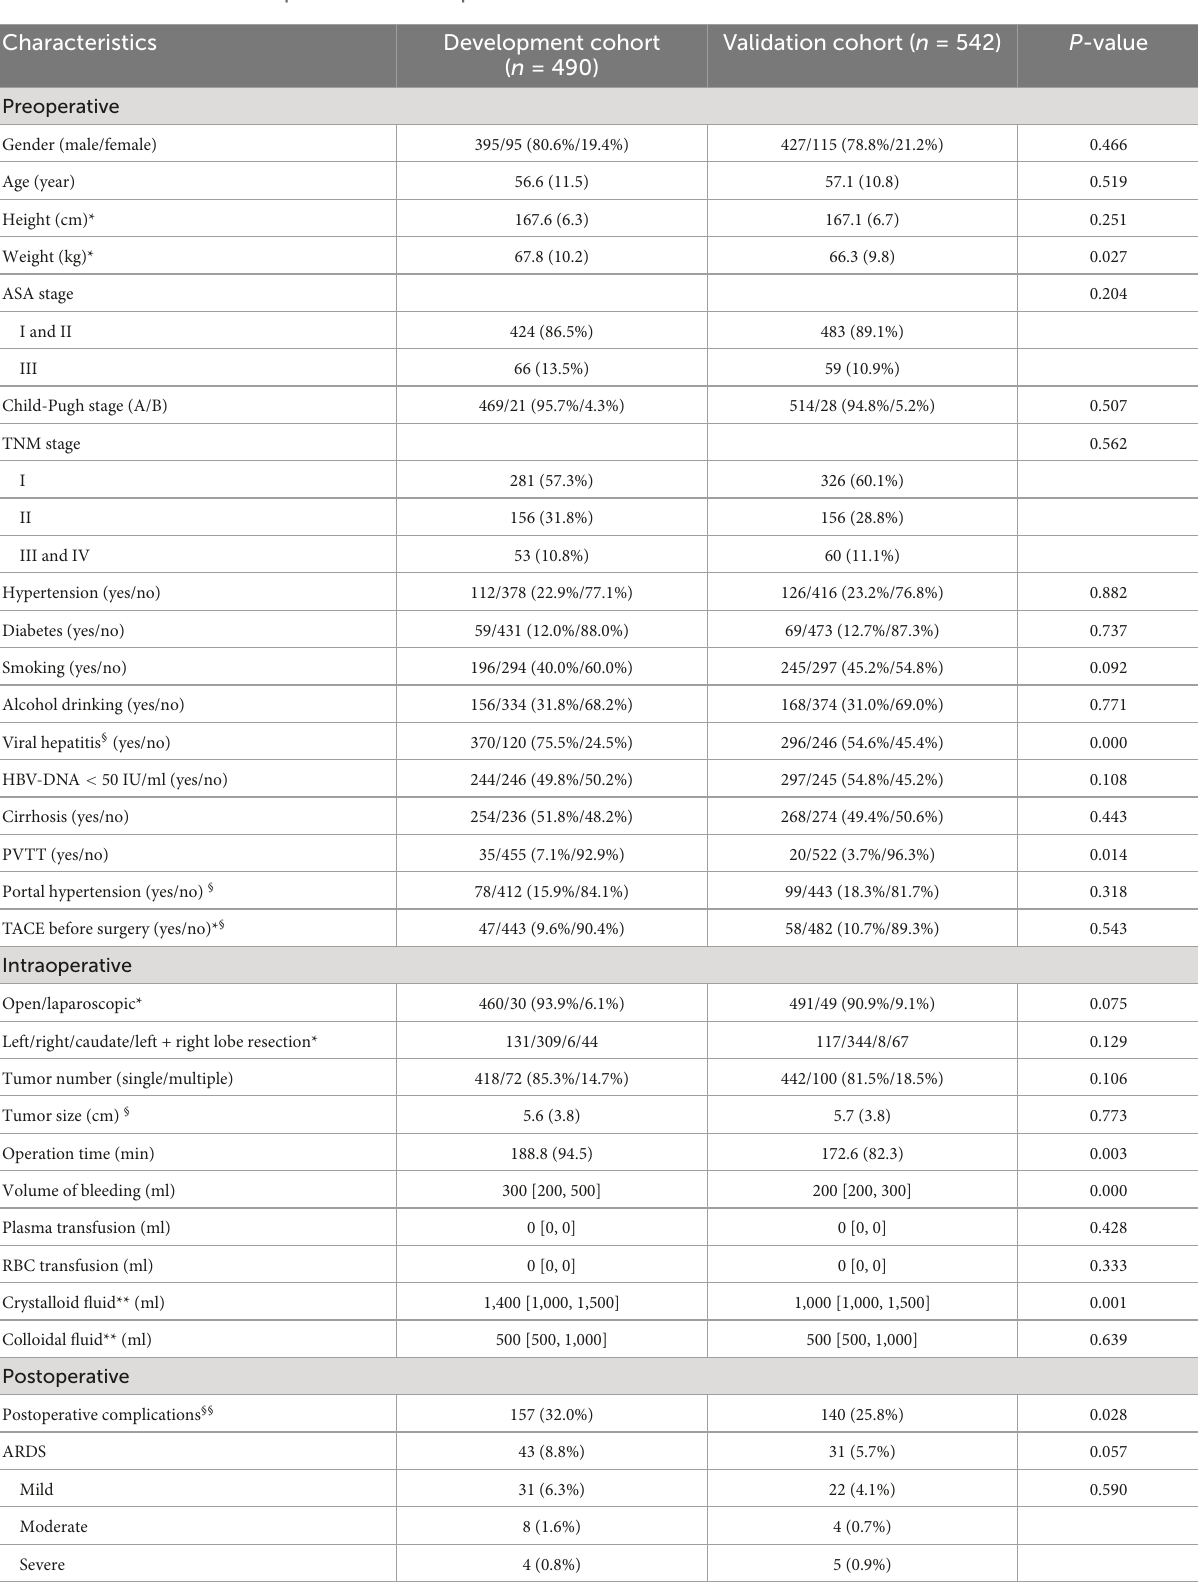
TABLE 1 Clinical characteristics of patients in the development cohort and validation cohort.